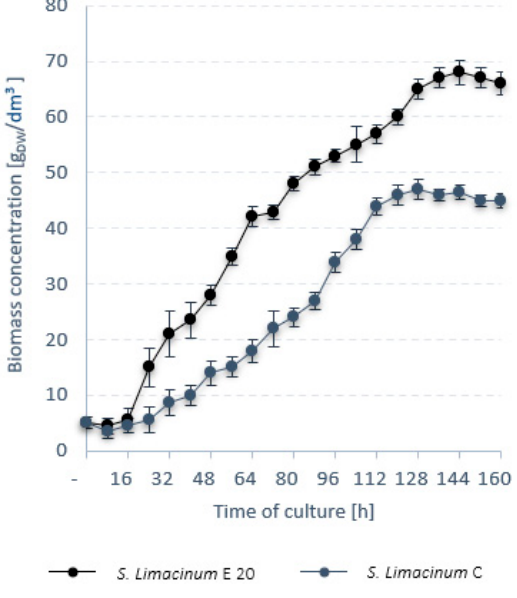
Figure 1. Trends in microalgal biomass.